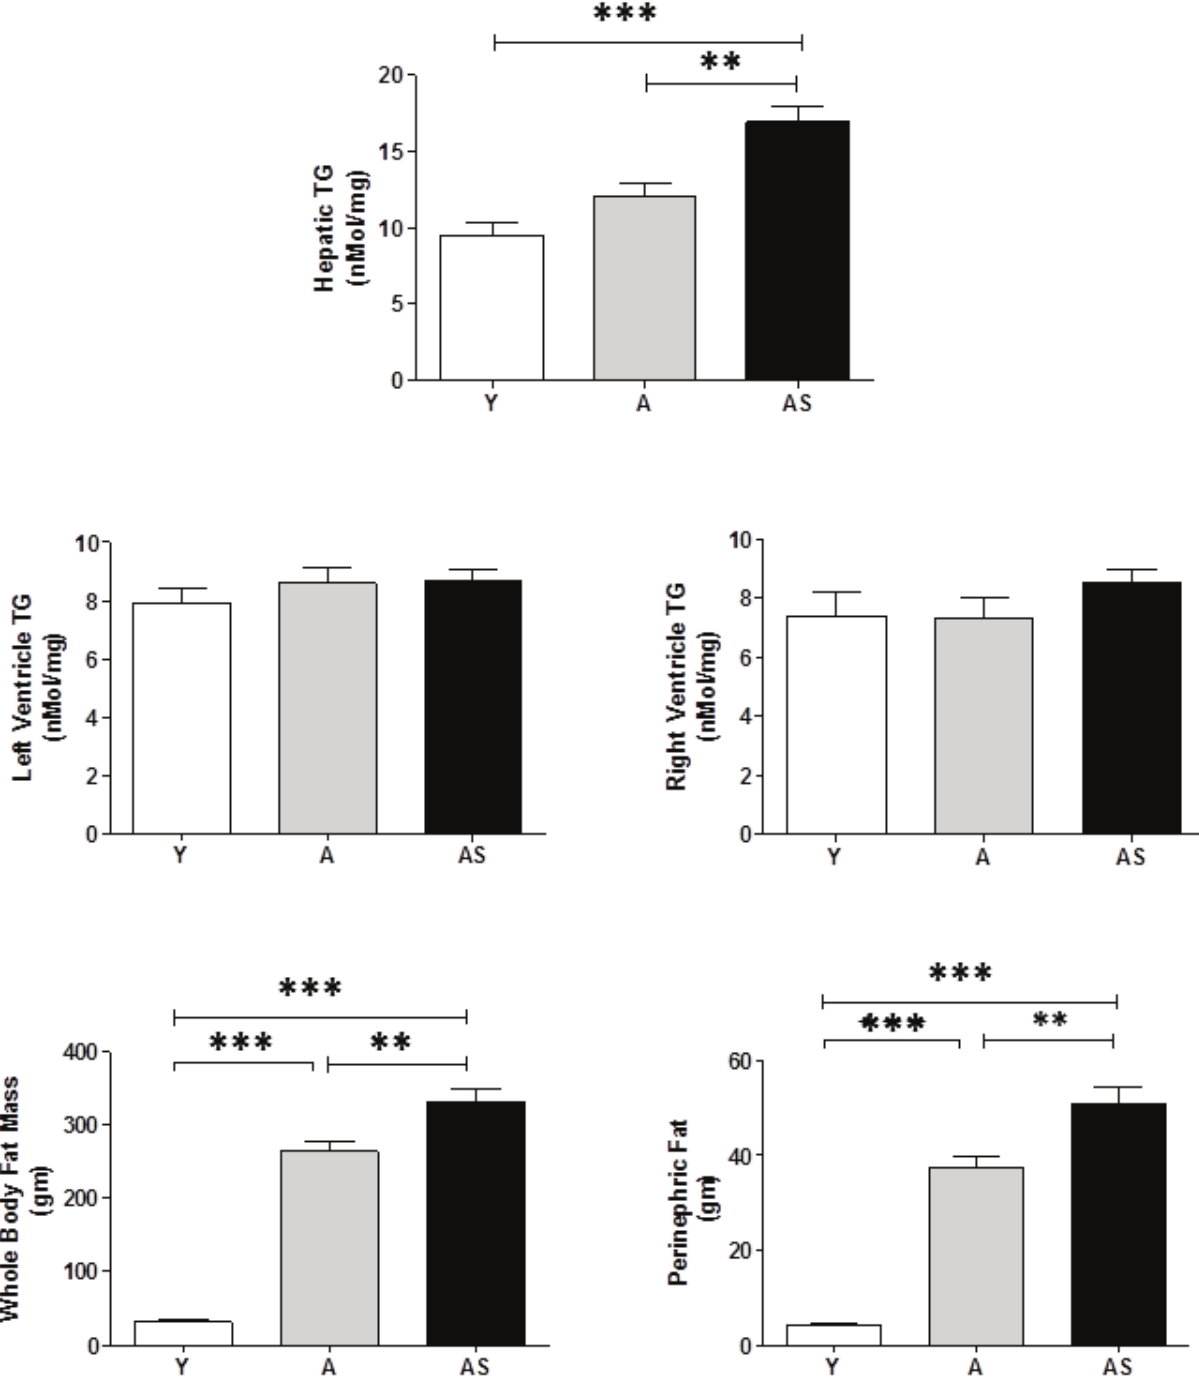
Figure 4. The effects of age ± sucrose supplementation on hepatic and cardiac triglycerides, and body adiposity. Hepatic TG was not significantly increased with aging alone, but was with sucrose supplementation. Cardiac TG in the left and right ventricles did not change when comparing rats that were young (Y), aged (A), and aged on sucrose (AS). However, perinephric fat increased with aging ± sucrose supplementation, as did whole-body fat mass. gm = g. * p < 0.05; ** p < 0.01; *** p <